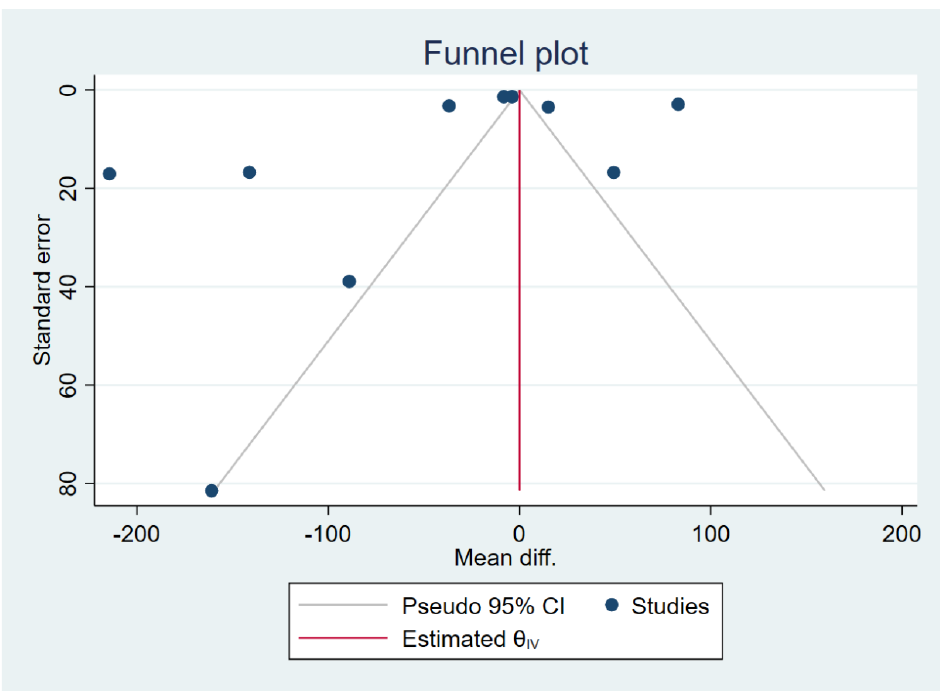
Figure 10. The funnel plot demonstrated the distribution of the mean difference of IL-12 levels between severe and uncomplicated malaria from each study. In addition, the funnel plots showed the asymmetrical distribution of the mean differences and the standard error (se) of the mean differences.